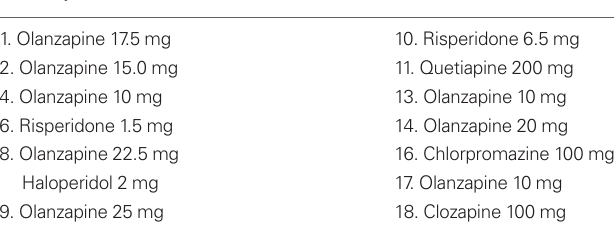
Table 2 | Patient medication